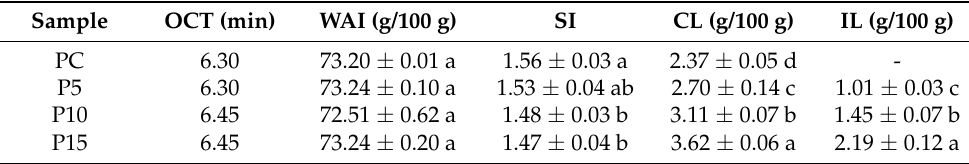
Table 1. Cooking properties of fresh